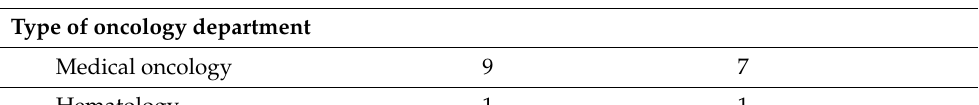
Table 1. Cont. Characteristics Type of oncology